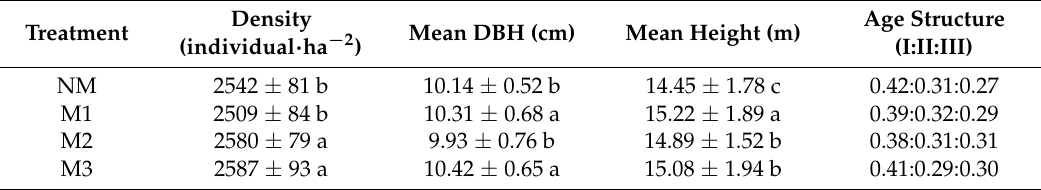
Table 1. Characteristics of the four experimental stands.